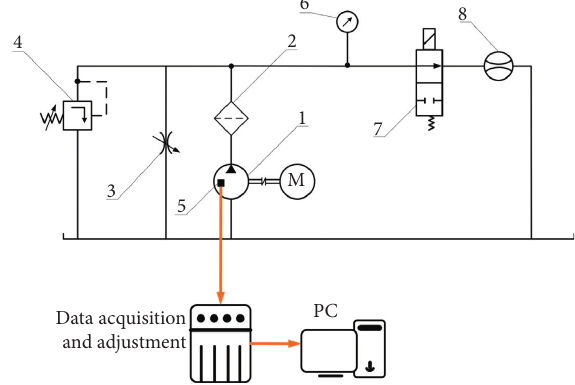
Figure 3: Experimental schematic diagram. (1) Seawater axial piston hydraulic pump. (2) Filter. (3) Throttle valve. (4) Safety valve. (5) Vibration sensor. (6) Pressure sensor. (7) Switch valve. (8) Flow